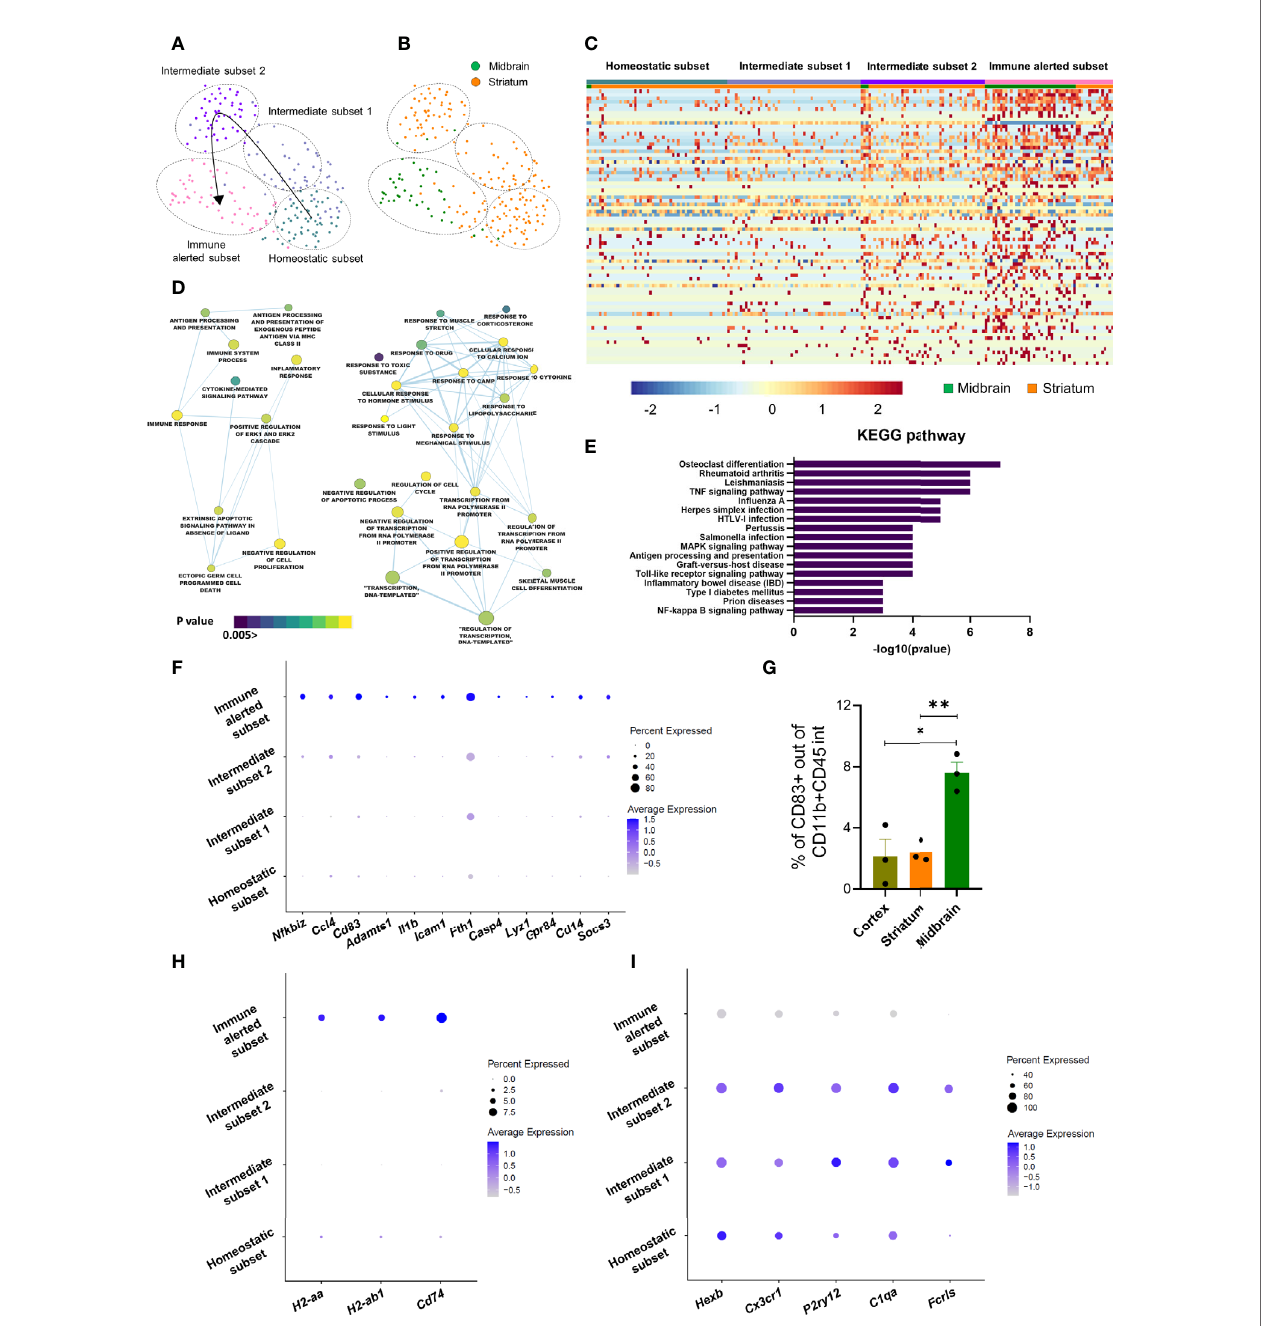
FIGURE 2 | Microglia within the nigrostriatal pathway segregate into speci fi c immune subsets. (A) UMAP plot of the re-projected microglia cluster showing four distinct subsets: homeostatic (in grey), intermediate 1 (in pale blue), intermediate 2 (in purple) and immune alerted (in pink). (B) UMAP representation showing 210 microglial cells, with 41 cells from the midbrain (in green) and 169 cells from striatum (in orange). (C) Heatmap showing clustering analysis of single cells, featuring 78 differential expressed genes across the four subsets (q value < 0.05). Color bar represents z-scores (from low z-score in blue to high z-score in red) ( Table S2 ). (D) Cytoscape network analysis of gene ontology terms identi fi ed by DAVID analysis (p value < 0.05, node cut off q value < 0.1) of the 78 differentially expressed genes across microglia subsets ( Table S3 ). (E) Top 17 KEGG pathways identi fi ed by DAVID resulting from 78 differentially expressed genes ( Table S3 ). (F) Dot plot representing the expression of in fl ammatory genes across the microglia subsets. Circle diameter denotes percent expression; color code indicates average expression levels. (G) Percentage of CD83+ cells within the CD11b+CD45int population quanti fi ed by fl ow cytometry. Bars represent mean ± SEM (cortex in pale green; striatum in orange; midbrain in green). Unpaired Student t test (n = 3) (*p < 0.05, **p < 0.01). (H – I) Dot plots representing (H) antigen presenting cell markers and (I) homeostatic genes across the microglia subsets. Circle diameter denotes percent expression; color code indicates average expression